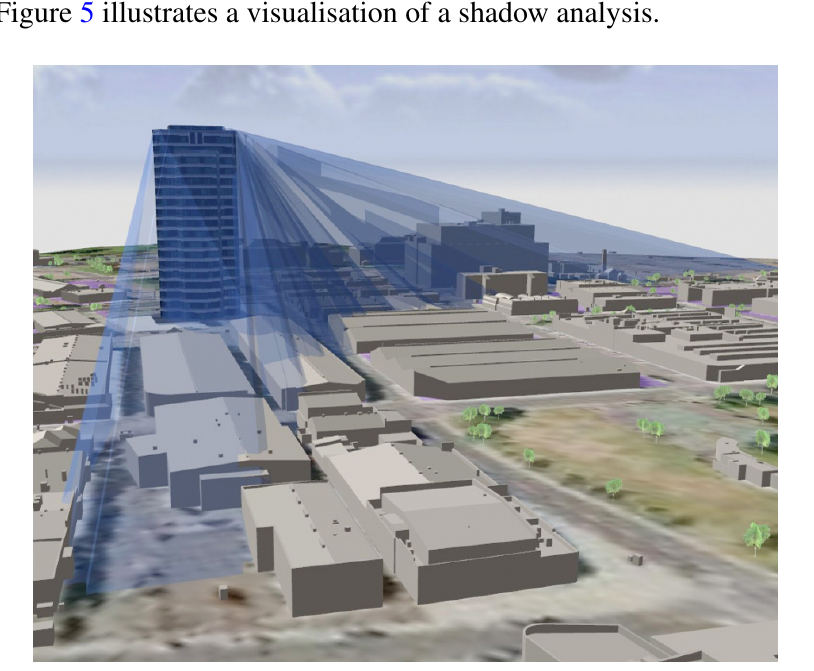
Figure 5. Estimating the shadow cast by a building for a few positions of the sun.